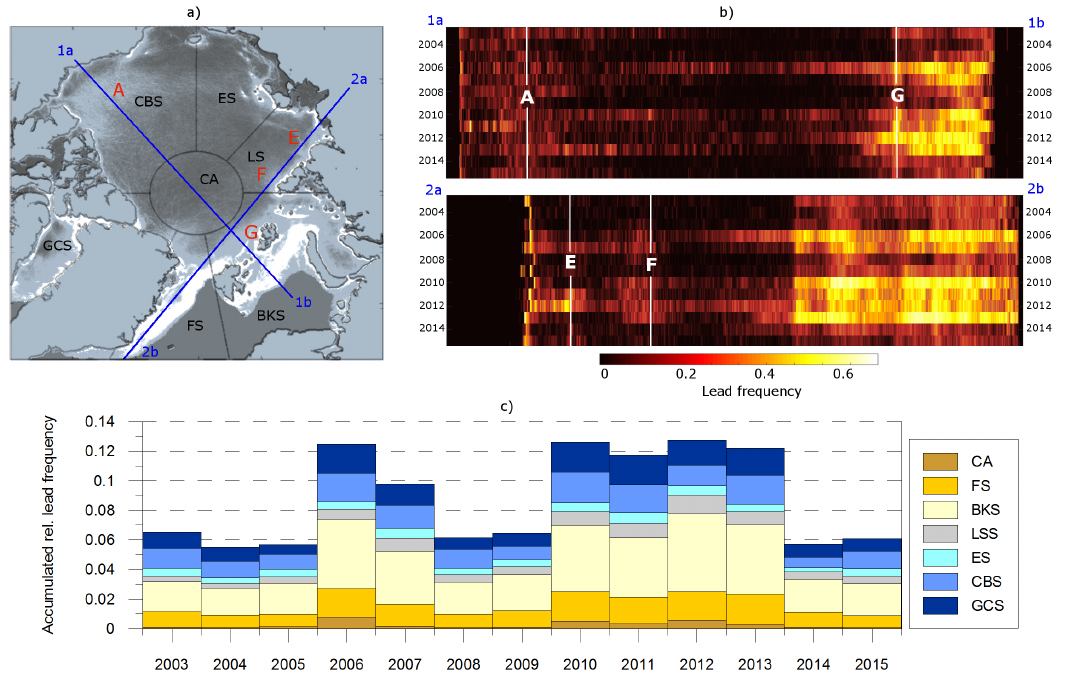
Figure 6. ( a ) Sub-regions Central Arctic (CA), Fram Strait (FS), Barents and Kara Seas (BKS), Laptev Sea (LS), East Siberian Sea (ES), Chukchi and Beaufort Seas (CBS) and Greenland and Canadian Seas (GCS) and transects used for the retrieval of lead dynamics; ( b ) Hovmoeller diagrams for transects 1 and 2 with start and endpoints indicated and positions of highlighted regions (compare Figure 5) indicated; ( c ) bar chart of the annually accumulated relative lead frequency per